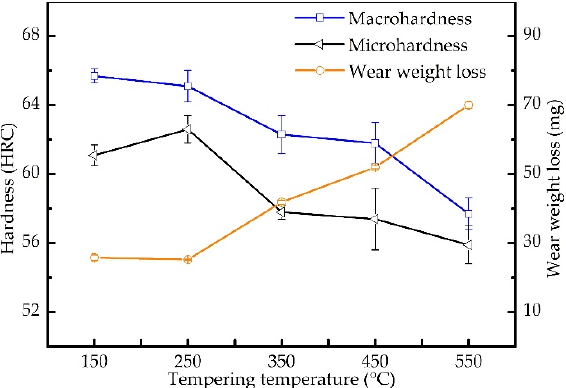
Figure 7. Macrohardness, microhardness of the matrix, and wear resistance of V3 tempered at different temperatures.